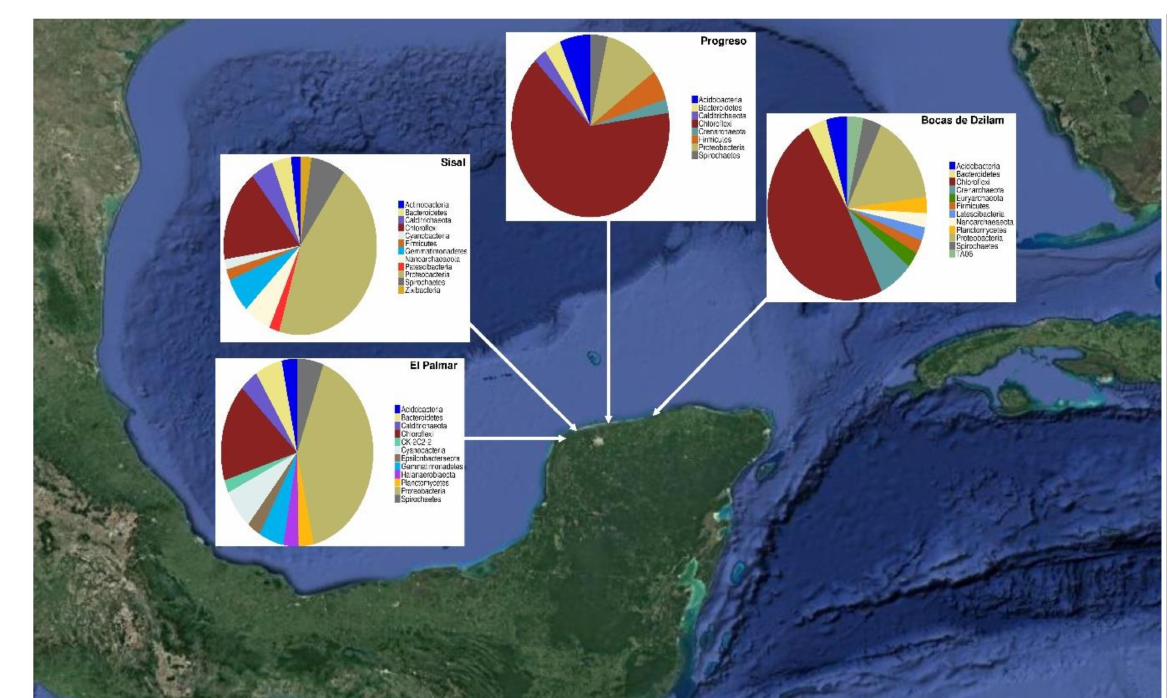
Figure 4. Microbial landscape of the Yucatan coast. Changes in the diversity and abundance of microbial species present in four locations on the Yucatan coast are